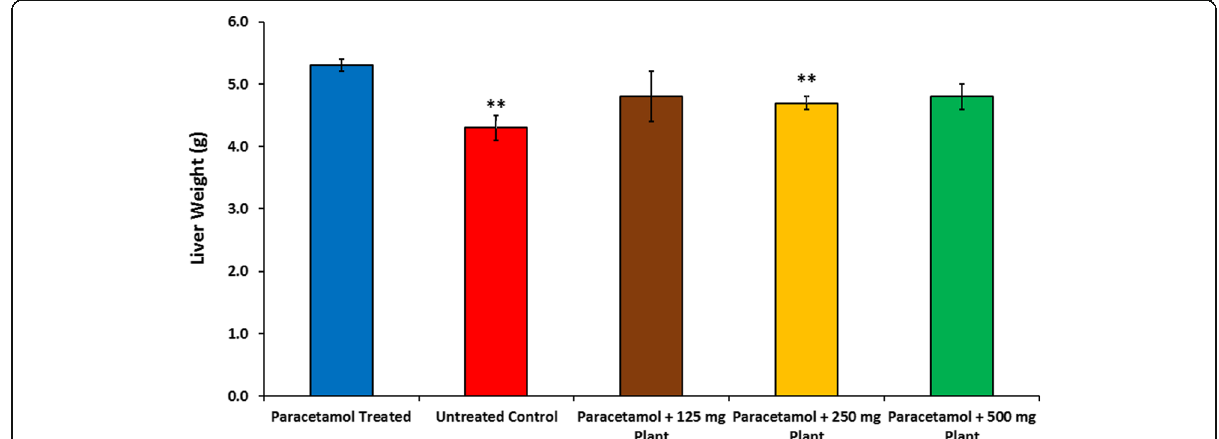
Fig. 6 Bar charts showing the effect of A. orientalis on liver weight in paracetamol treated, untreated control, paracetamol A. orientalis pretreated 125, 250, 500 mg/kg BW mice groups. Note that liver weights were reduced compared to paracetamol treated mice group and the reduction was significant at untreated control and A. orientalis pretreated 250 mg/kg BW dose, respectively. Data are presented as: mean ± SEM, n = 6, ** P < 0.05 showed moderate significant